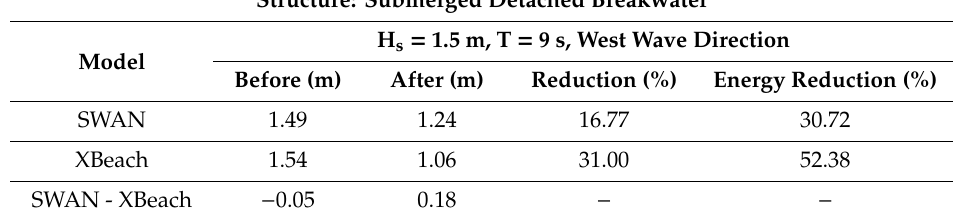
Table 2. Comparison of numerical model results before and after each structure considering the west wave direction